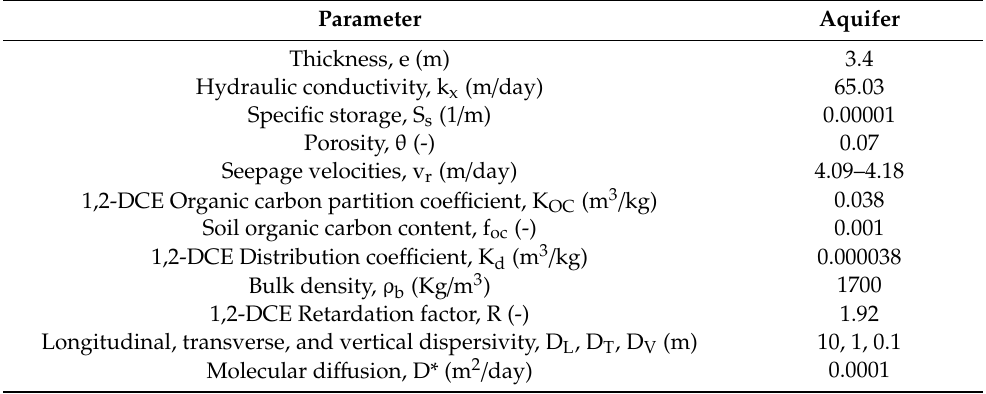
Table 1. Hydrogeological and chemical properties of the aquifer and contaminants for the field case.